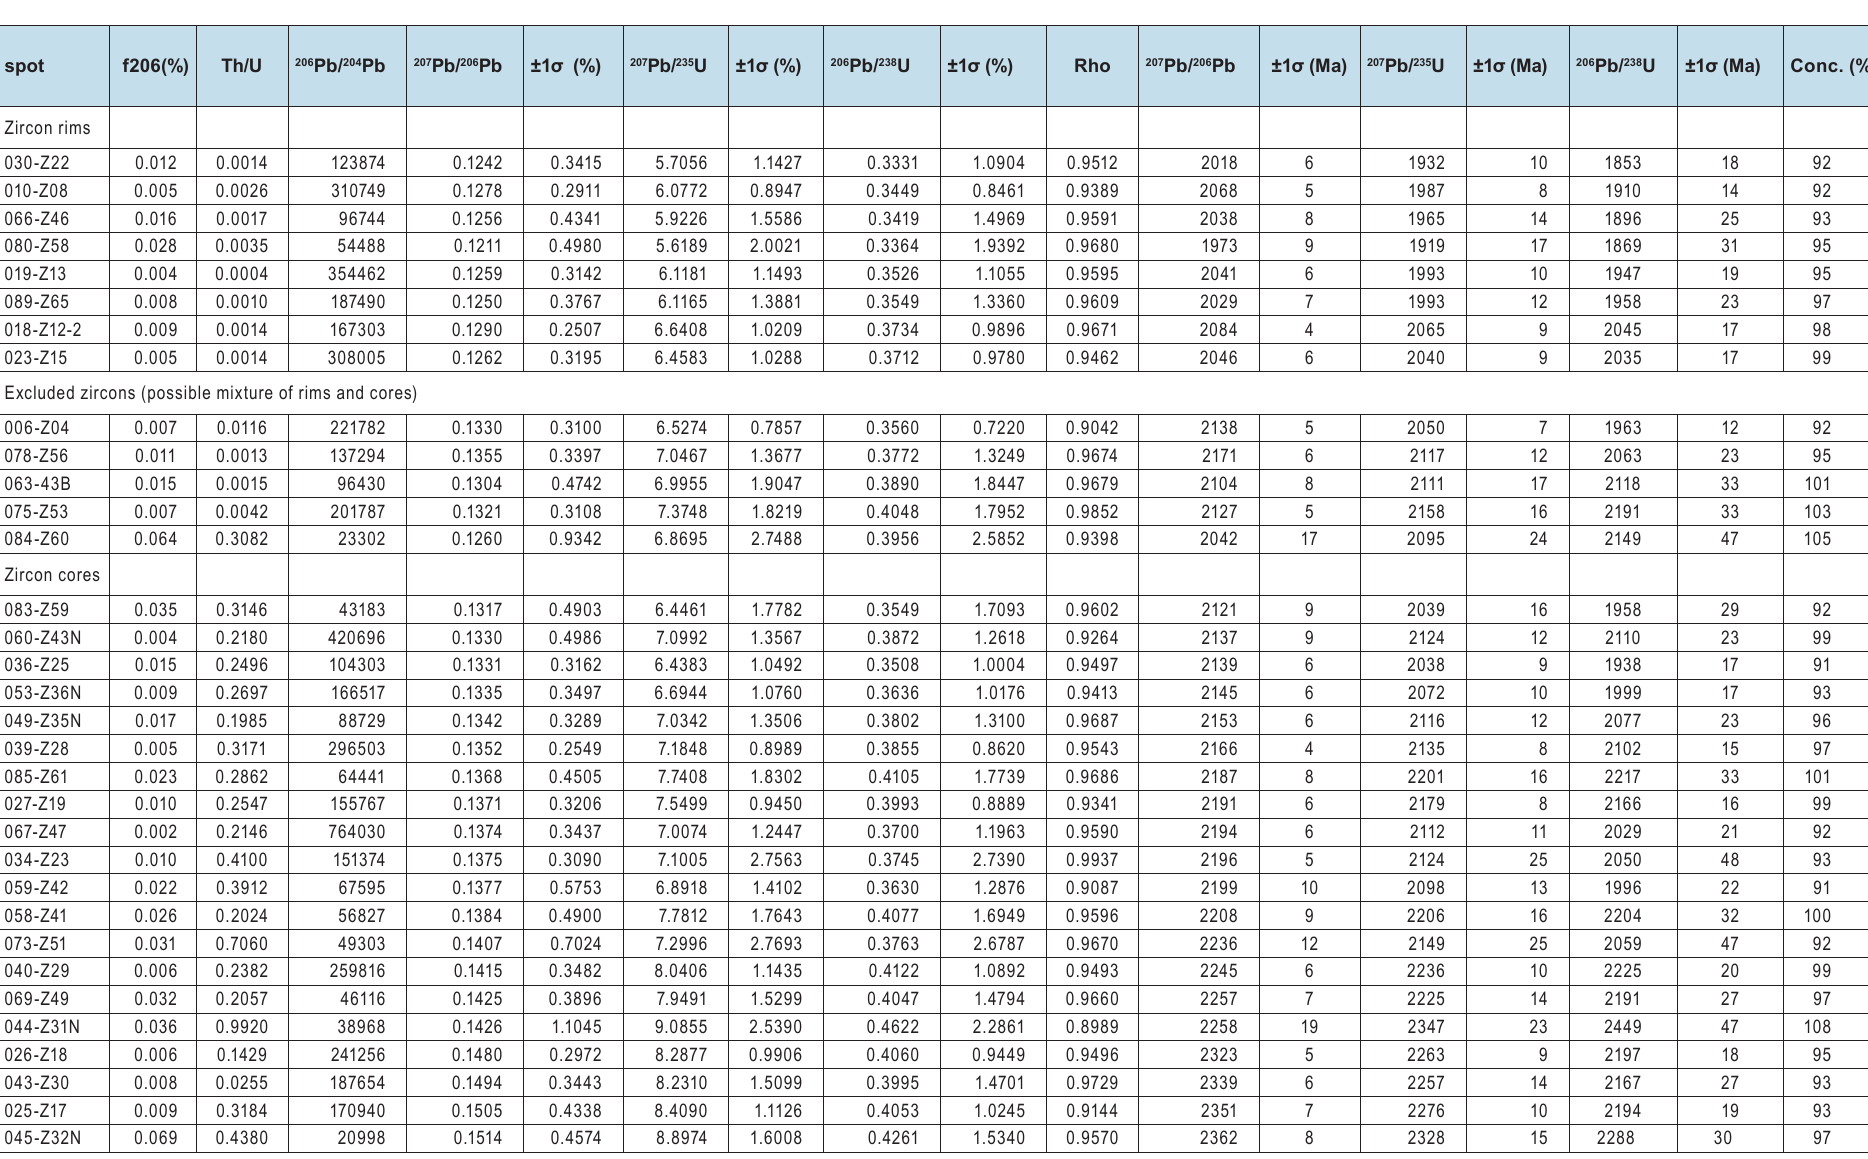
TABLE – 1 U-Pb LA-ICPMS zircon